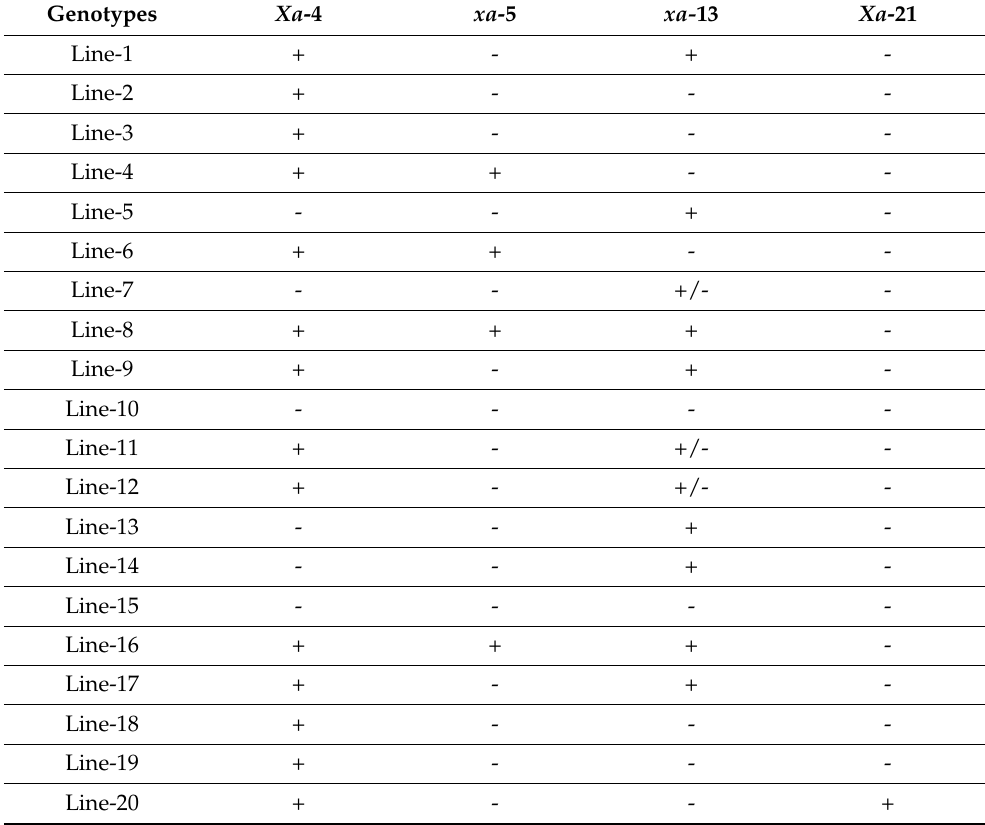
Table 1. PCR analysis of RILs for bacterial blight R